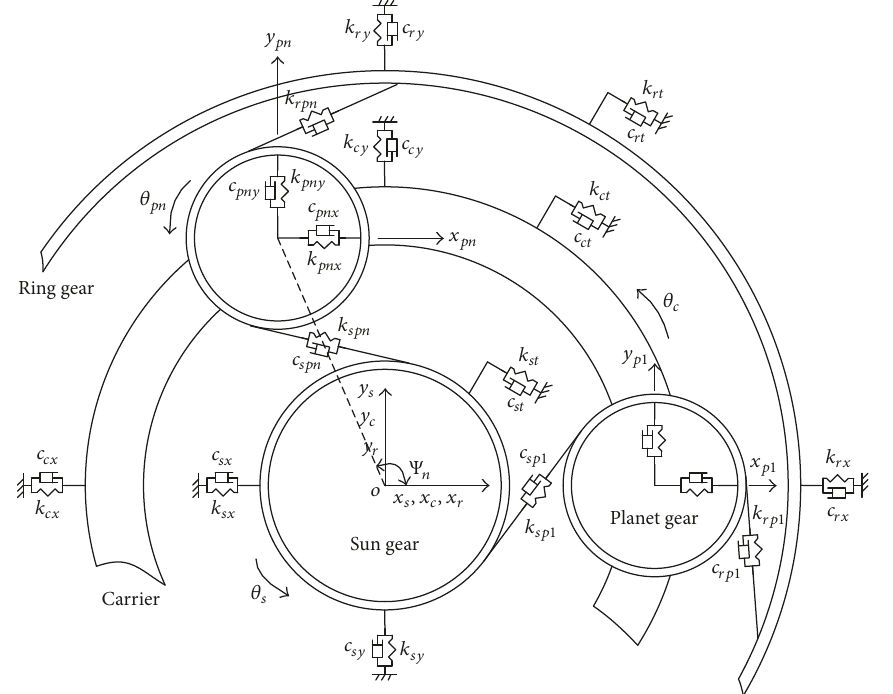
Figure 3: Dynamic model of a planetary gear set [16].